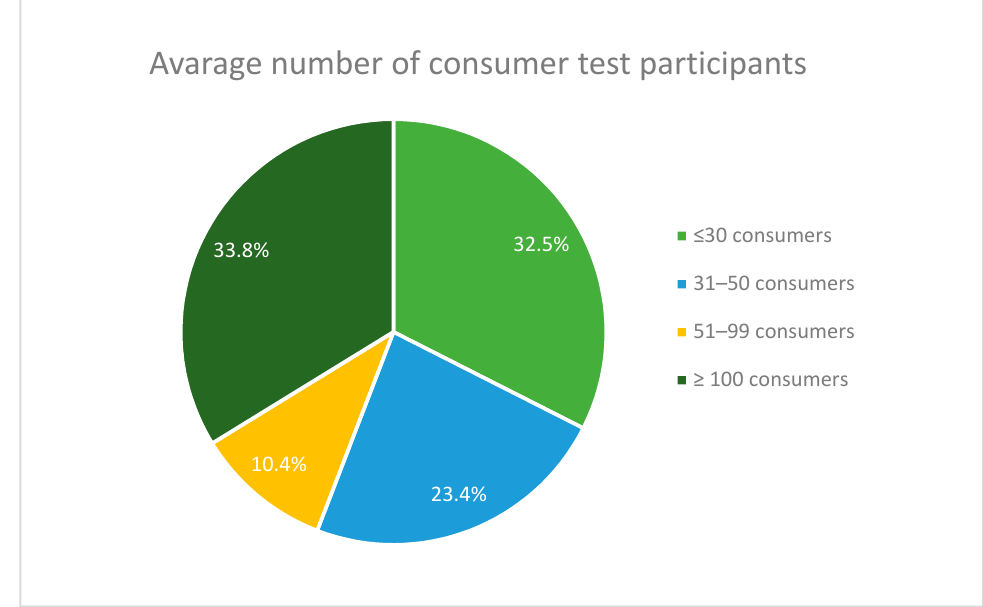
Figure 2. Average number of consumer test participants.